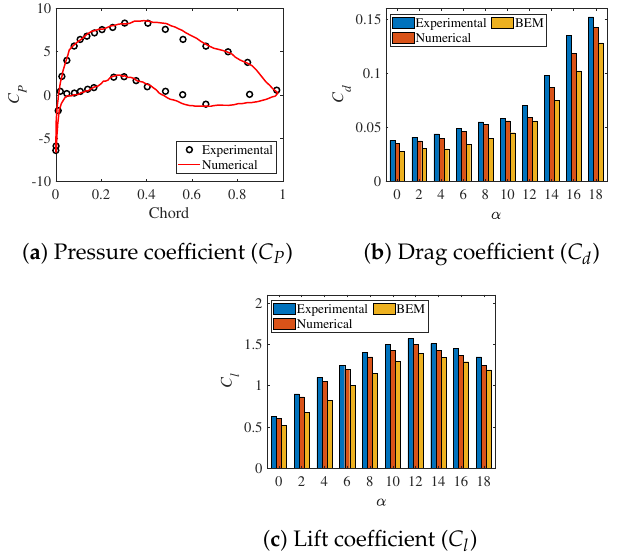
Figure 5. HAWT-S826: Illustration for ( a ) the pressure coefficient ( C P ) versus chord, ( b ) drag ( C d ) and ( c ) ( C l ) lift coefficients versus varying angle of attack ( α ). Numerical results are plotted against experimental results and BEM (taken from Krogstad et al. [37,38]) at a Reynolds number of 1 × 10 5